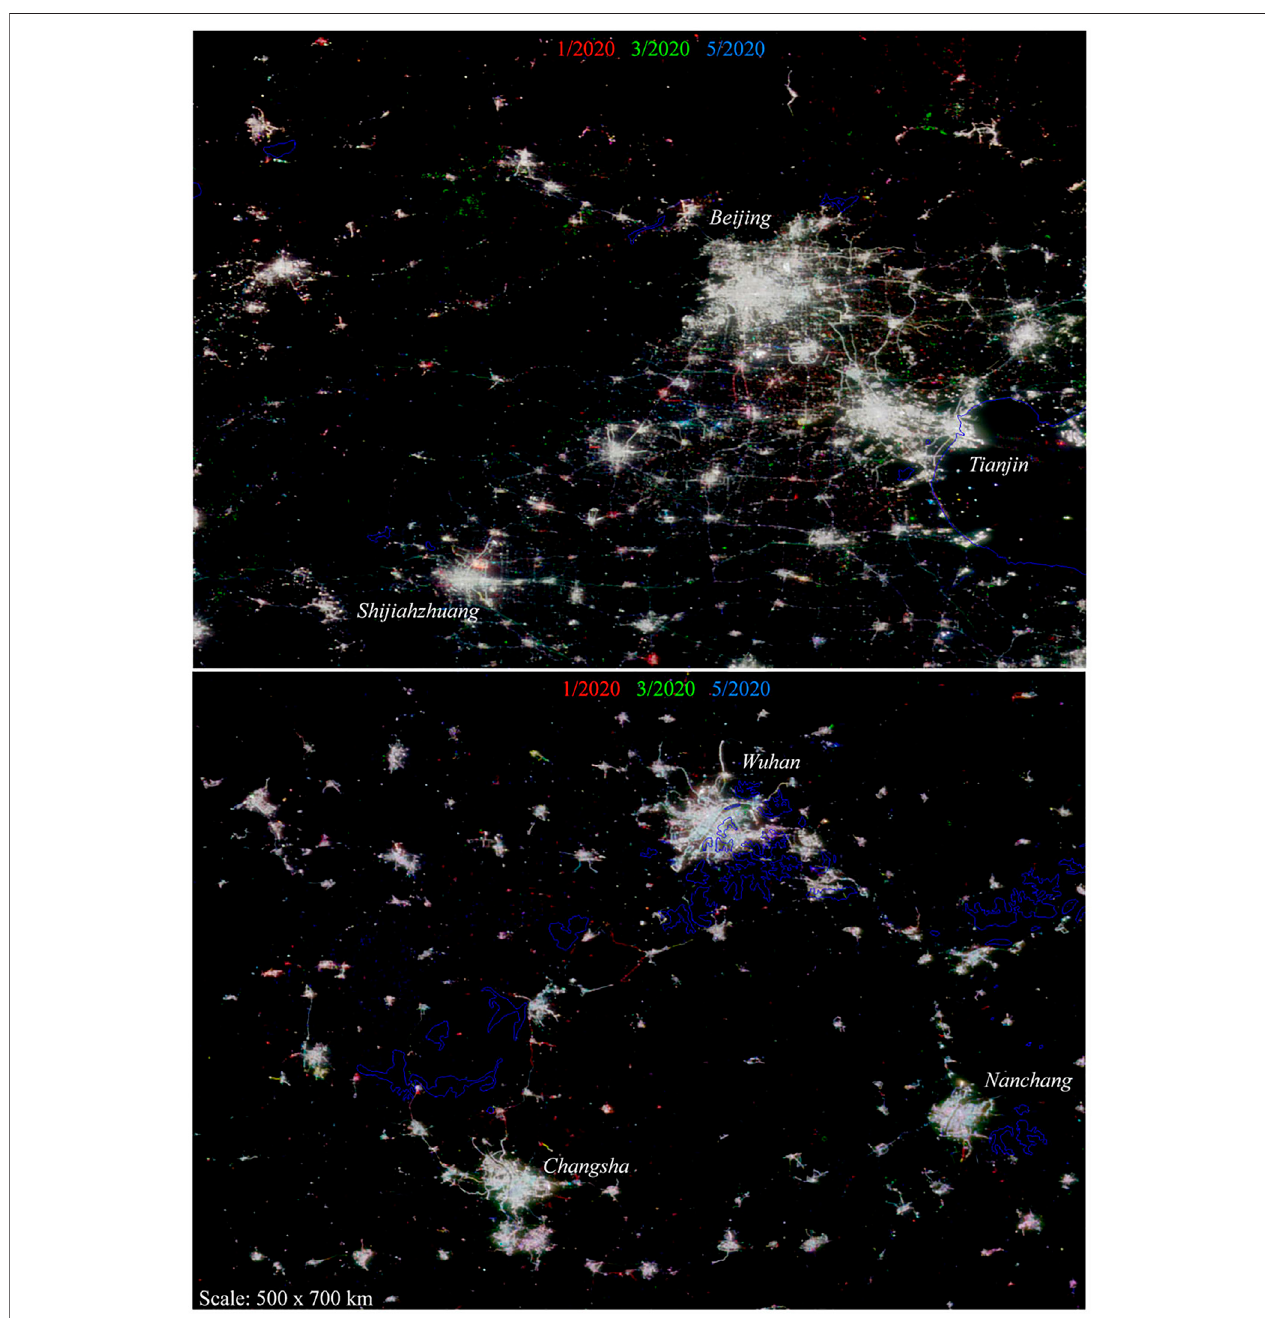
FIGURE 7 | Night light stability in China. Tri-temporal composites of monthly mean radiance for early 2020 shows almost all lights as unchanging (shades of gray), with a few small exceptions. No evidence for persistent or widespread reduction in night light during the 2020 lockdowns. Color implies change. Warmer colors